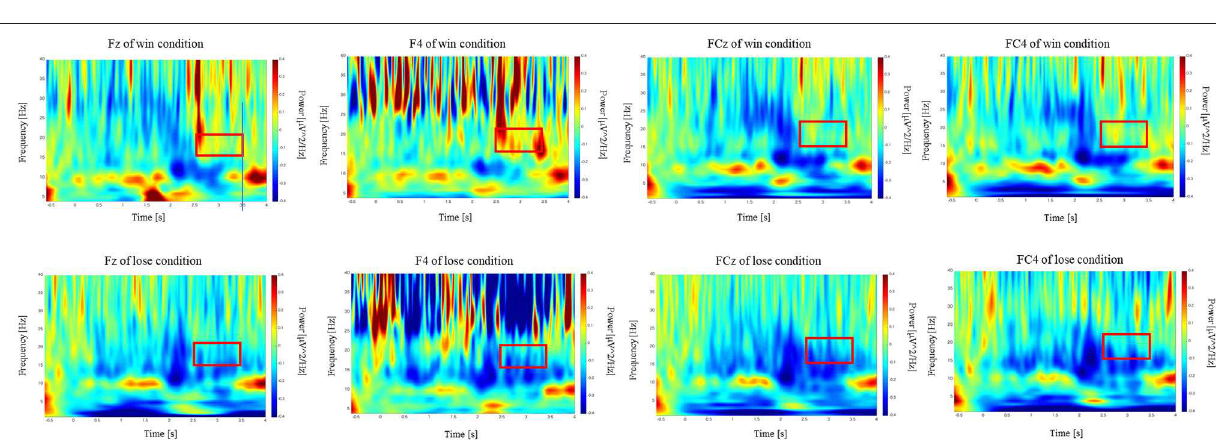
FIGURE 4 | Scalogram showing power at the F4, FCz, and FC4 electrodes during the CH session in terms of frequency and time. Vertical axes show the frequency from 4 to 40Hz. Horizontal axes show the time course of the trial. The power during the outcome period in the 15–22Hz frequency range (red box) was higher in the win trials compared with that in the lose